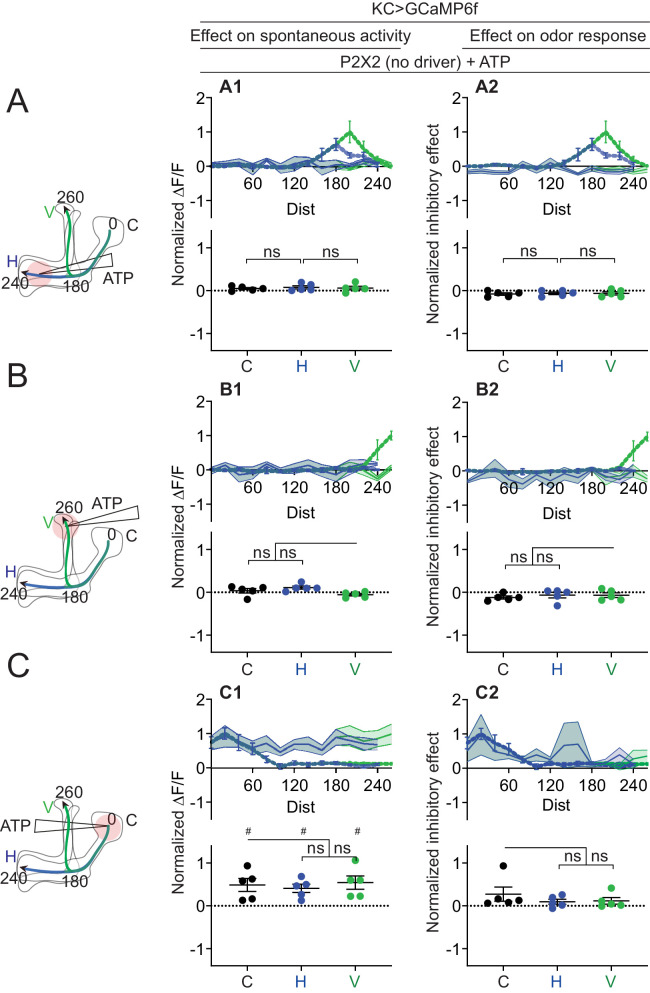
Quantification of effect of ATP on negative control (UAS-P2X2 only).Rows: Local application of ATP (0.75 mM) in the horizontal lobe (A1–A2), vertical lobe (B1–B2) or calyx (C1–C2). Columns: KC responses to APL activation by ATP (A1–C1), or the normalized inhibitory effect of APL neuron activation on KC responses to isoamyl acetate (A2–C2). Data shown are mean responses in each segment (averaged over time in the gray-shaded periods in Figure 6). The color of the curves matches the vertical (green) and horizontal (blue) lobular branches depicted in the schematics shown on the left. The responses were normalized to the segment (upper panels) or data point (lower panels) with the largest absolute value in the corresponding experimental conditions (columns 2 and 3 in Figure 7 for column 1; columns 4 and 5 in Figure 7 for column 2). N: five neurons, three flies. # p<0.05, one-sample t-test, vs. null hypothesis (0) with Holm-Bonferroni correction for multiple comparisons. ns, p>0.05, one-way ANOVA with Holm-Sidak’s multiple comparisons test, comparing the stimulated site vs. the unstimulated sites. Paired t-test comparing the response at segment 200 vs. 260 on the vertical branch gives p = 0.2218 (A1), p = 0.9397 (A2).